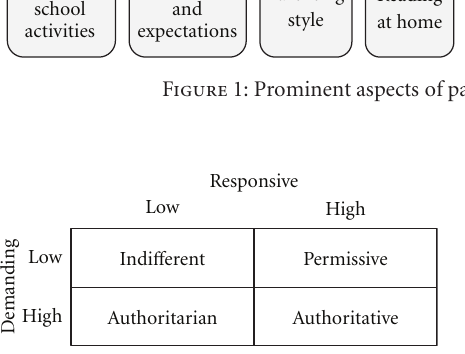
Figure 2: A cross of responsive and demanding parenting, yielding four distinct